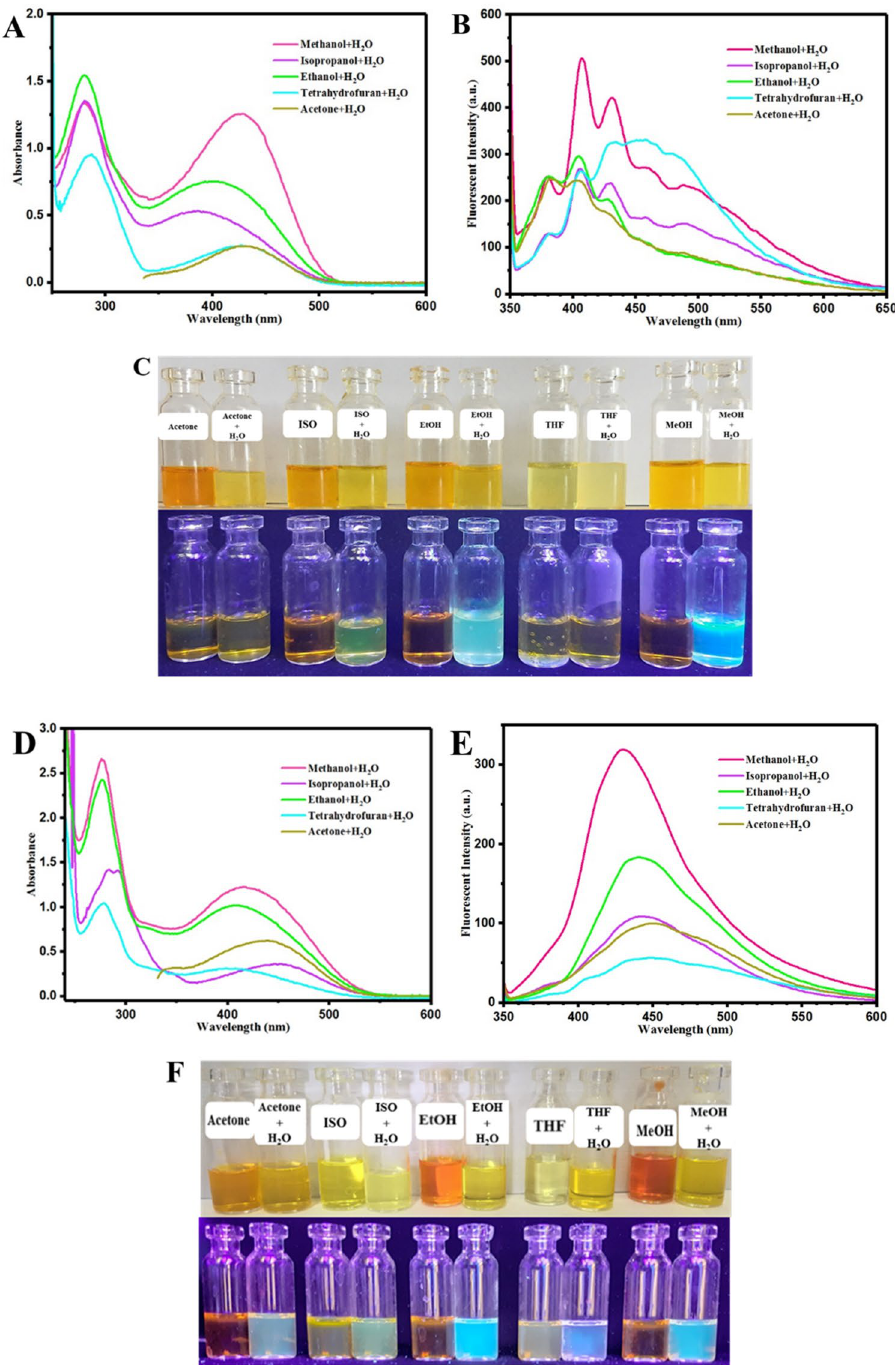
Figure 7. Hydrochromism plots in UV–Vis and fluorescence spectroscopy for ( A ) and ( B ) OX 1 -Naph and ( D ) and ( E ) OX 2 -Naph solutions and also photographs of hydrochromism phenomenon for ( C ) OX 1 -Naph and ( F ) OX 2 -Naph solutions before and after addition of water under visible light and UV irradiation (360